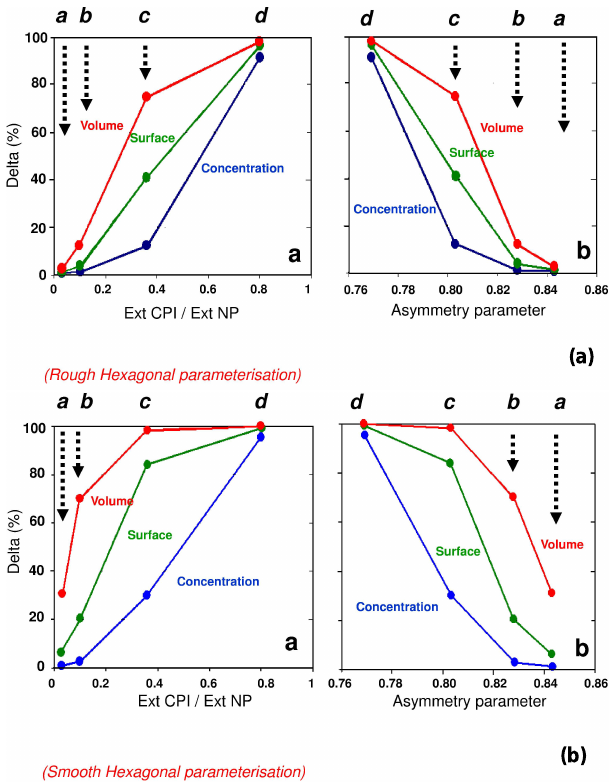
Fig. 8. Relative contribution of the ice particles (DELTA values) on number concentration, extinction (surface) and liquid/ice water content (volume) measurements as a function of: the REX extinc- tion ratio (CPI data to PN measurements) and the asymmetry pa- rameter, respectively. The data have been obtained during the cloud sequences labelled a, b, c and d (see Fig. 1). (a) Rough hexagonal crystals simulation. (b) Smooth hexagonal crystals